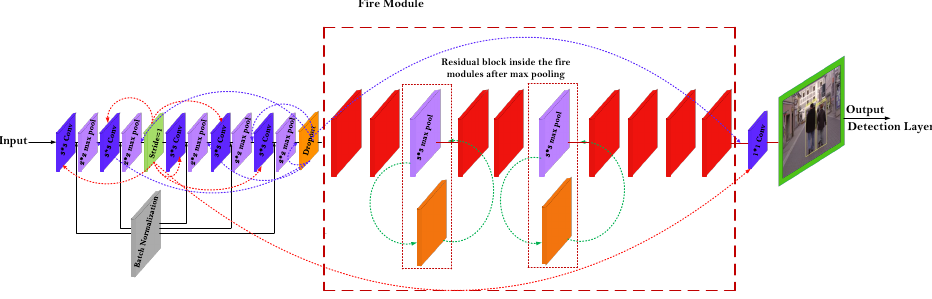
Figure 4. The structure of ReSTiNet. Fire modules are adopted from SqueezeNet, which shrinks the model. Then, residual connections are integrated from ResNet-50 network inside the fire modules to enhance the proposed ReSTiNet’s